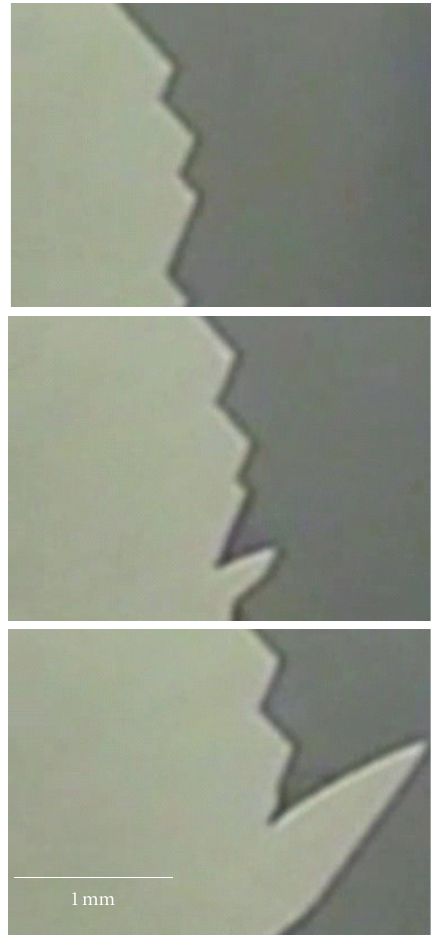
Figure 12: Growth behavior of faceted dendrite grown from crystal-melt